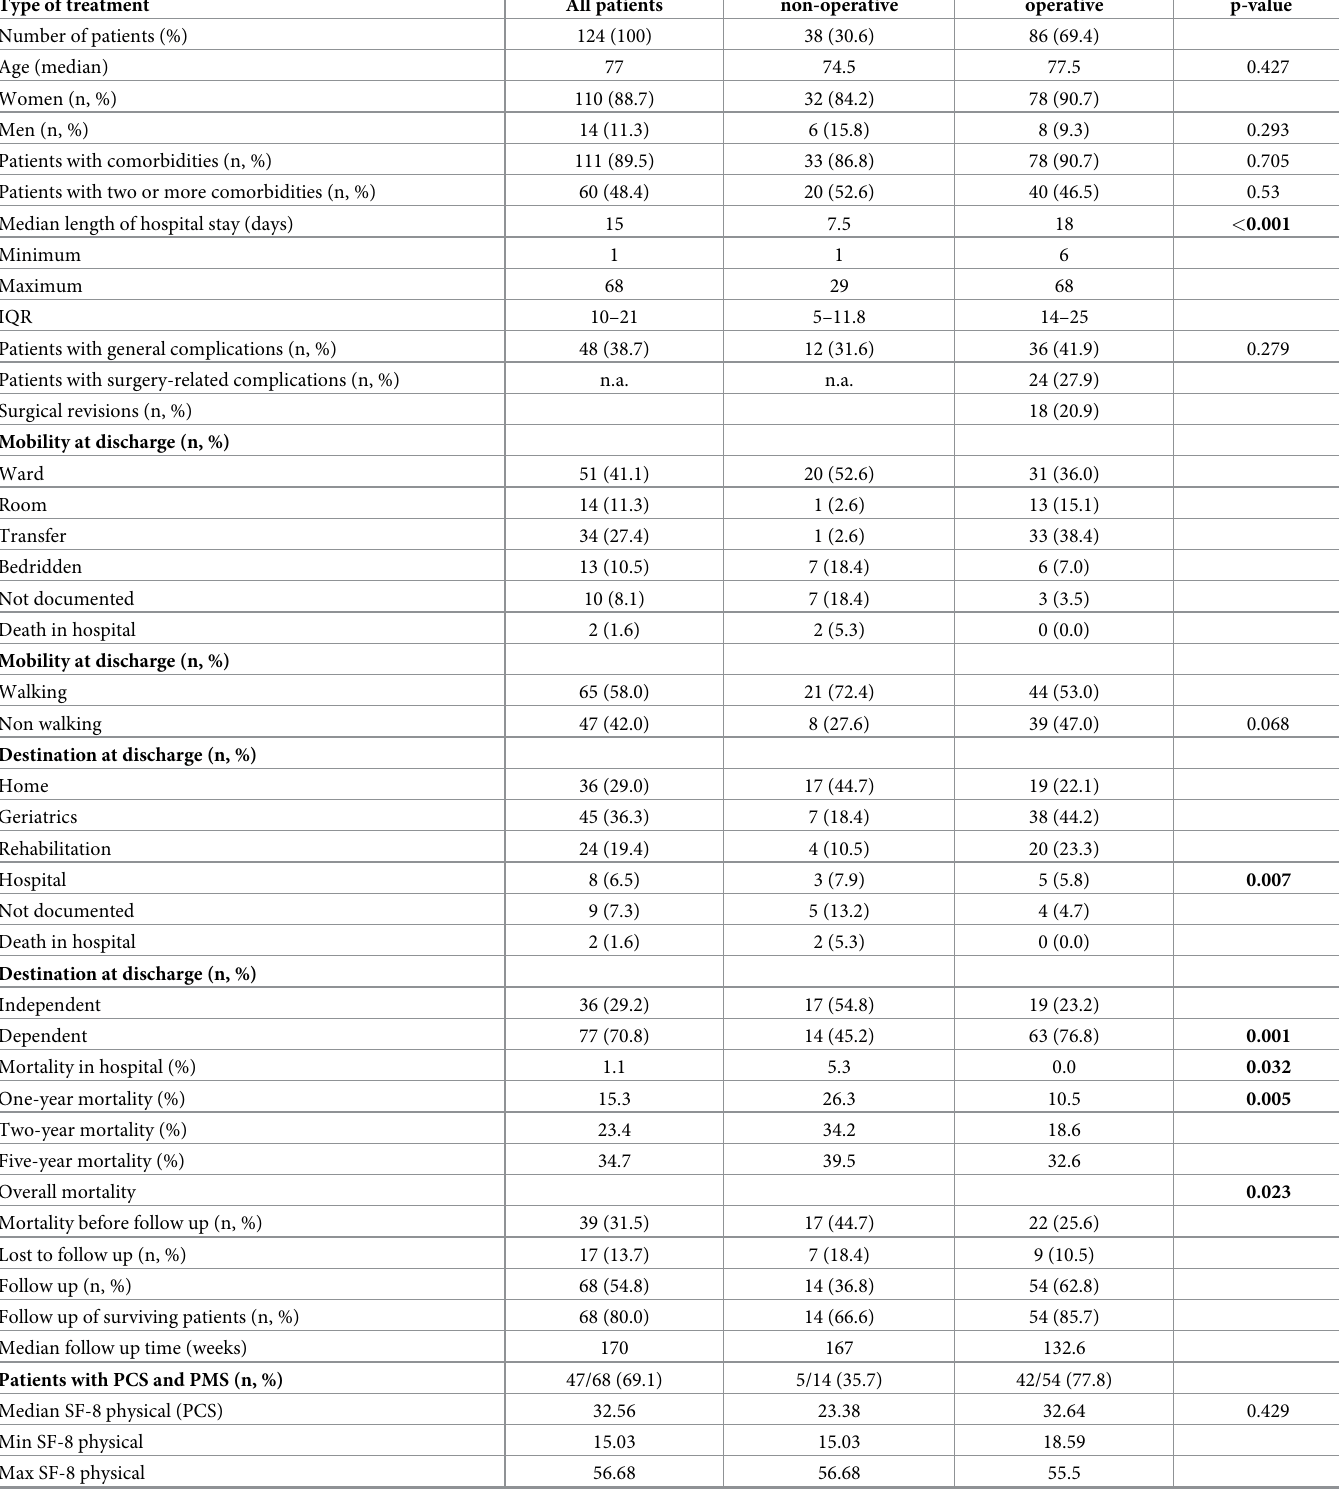
Table 7. Demographics, LoS, mortality, situation at discharge and at follow up of FFP type II patients, depending on type of